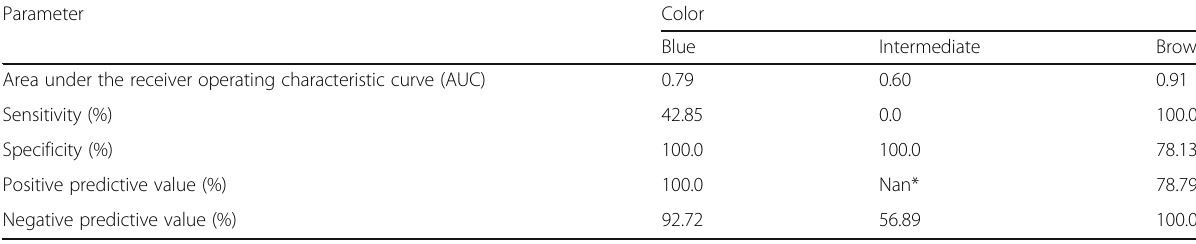
Blue Intermediate Brown